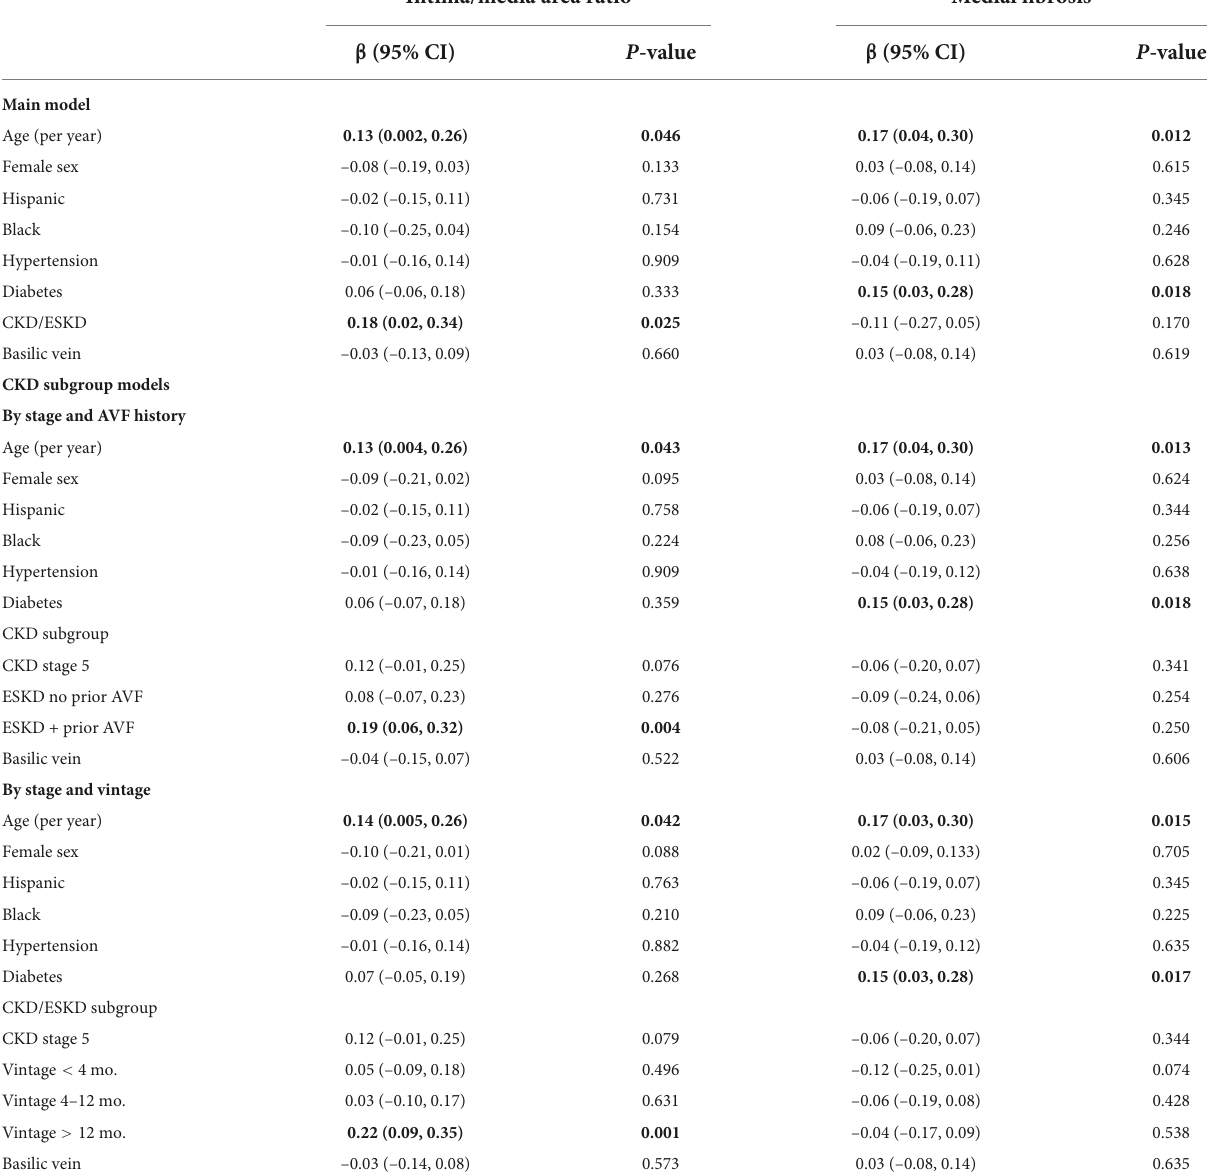
TABLE 3 Clinical predictors of venous morphometry using multivariate general linear regression